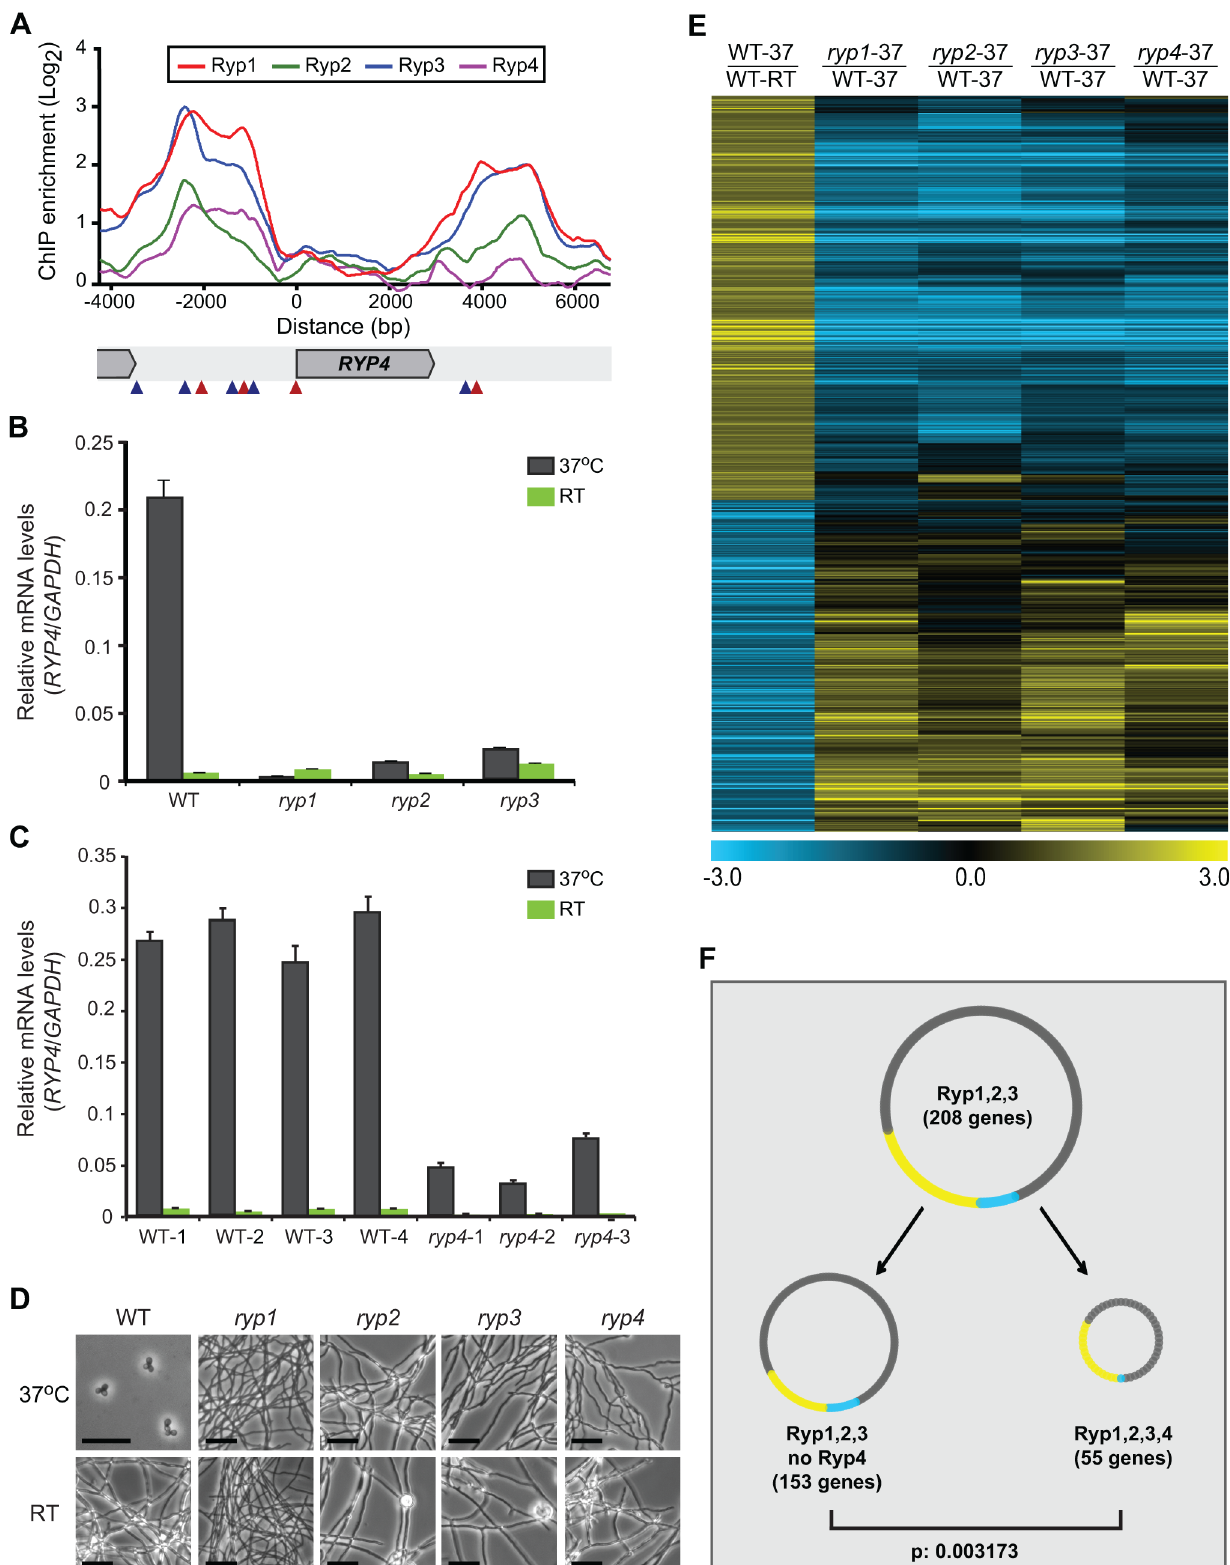
Figure 4. Ryp4 is required for yeast-phase growth. (A) ChIP-chip enrichment ratio versus genome coordinate for Ryp1, Ryp2, Ryp3, and Ryp4 ChIP events are shown at the RYP4 locus. Genome coordinates were adjusted to the start of the ORF. Motif A (red triangles) and Motif B (blue triangles) locations shown in these loci were identified using MAST. (B, C) qRT-PCR was used to quantify relative levels of RYP4 transcript in (B) ryp1 ,